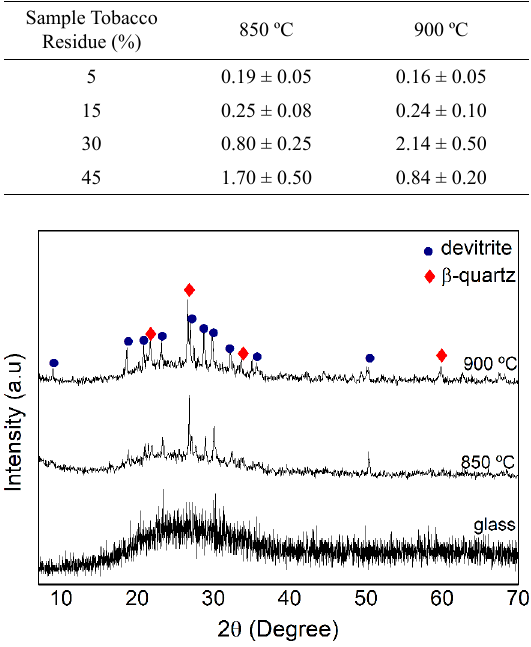
Figure 4. XRD diffraction patterns of the amorphous structure of the glass powder (as prepared) and partially crystalline structure of the glass foams containing 45 vol.% of tobacco residue, fired at 850 and 900ºC.